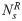
Cumulative probability distribution of NsR values for regional cuisines and their random controls.Cumulative distribution of NsR indicates the probability of finding a recipe having food pairing less than or equal to NsR. The data of regional cuisines as well as those of their controls were fitted with a sigmoid equation indicating that the P(NsR) values fall exponentially. The exponent α
Eq (1) refers to the rate of decay; larger the α more prominent is the negative food pairing in recipes of a cuisine. As evident from S2 Table, NsR distribution of the controls based on ‘Ingredient Frequency’ as well as ‘Category + Frequency’ displayed recipe level food pairing similar to real-world cuisines. On the other hand, as also observed at the level of cuisine (Figs 4 and 5), both the ‘Random Control’ as well as ‘Ingredient Category’ control deviate significantly.